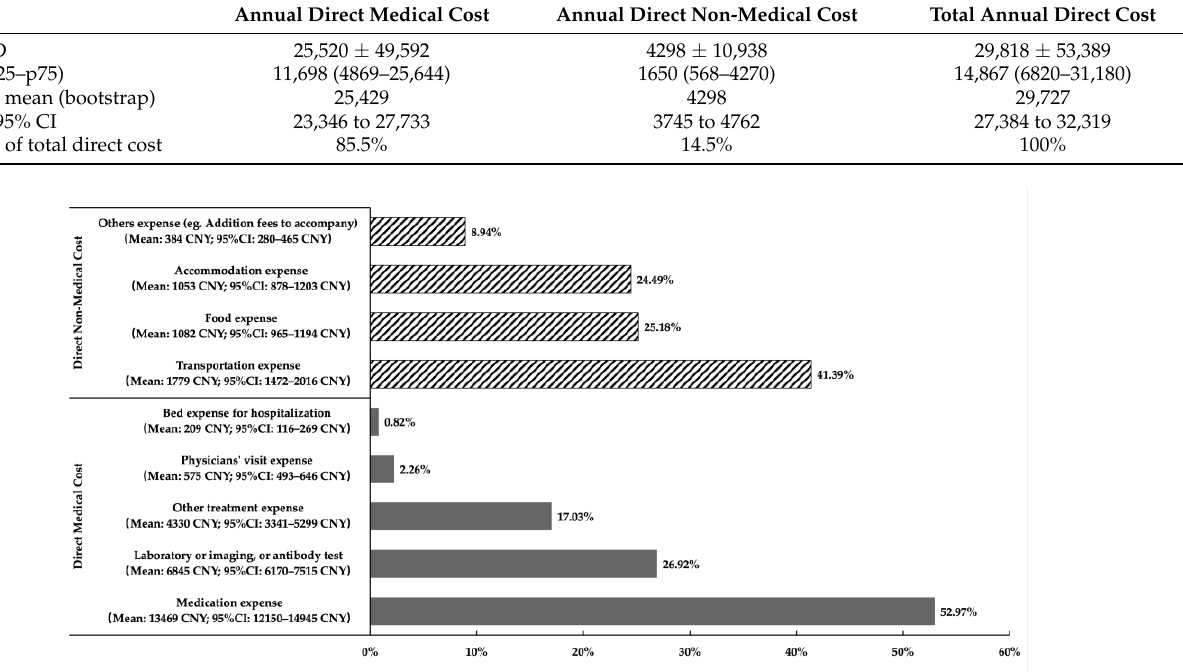
Figure 3. Proportion of direct medical costs and non-medical costs of SLE patients in China, calculated by the arithmetic means.